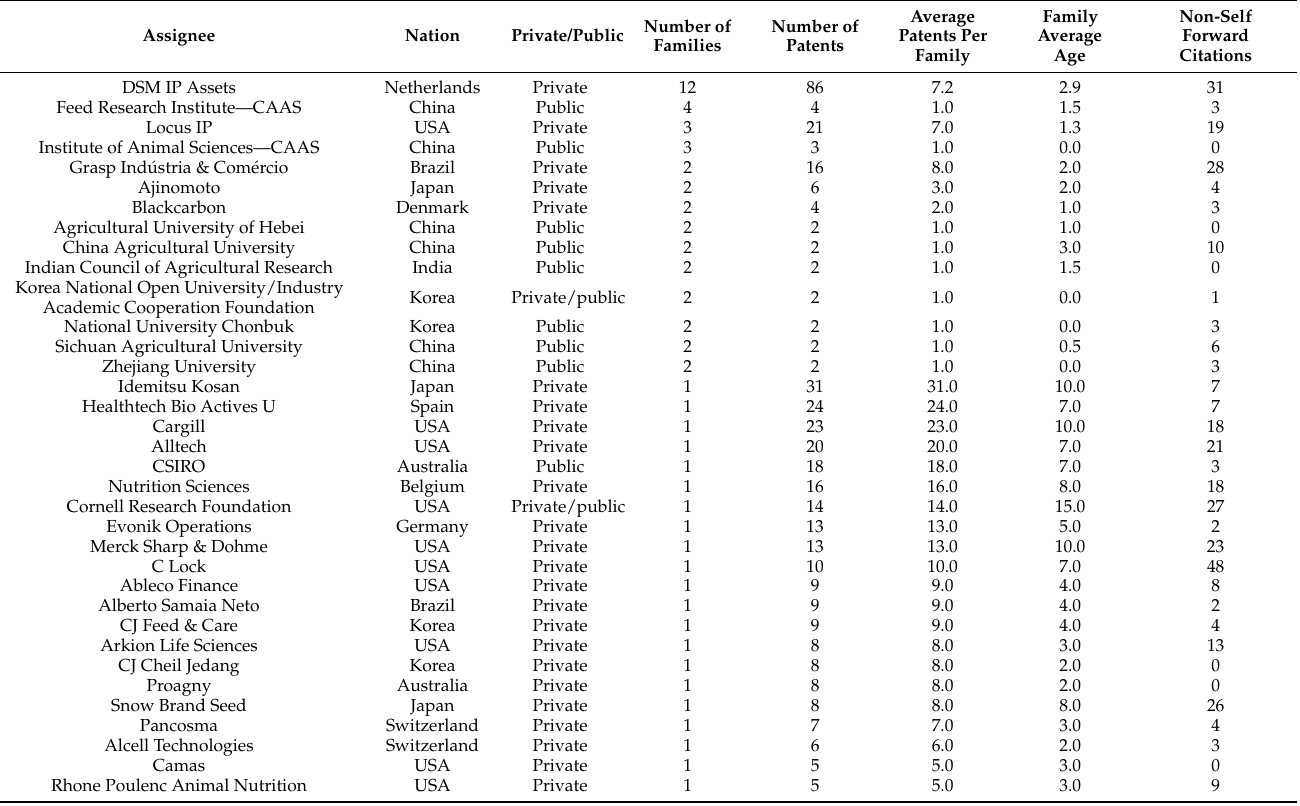
Table 3. Analysis of major assignees (>5 patents or >2